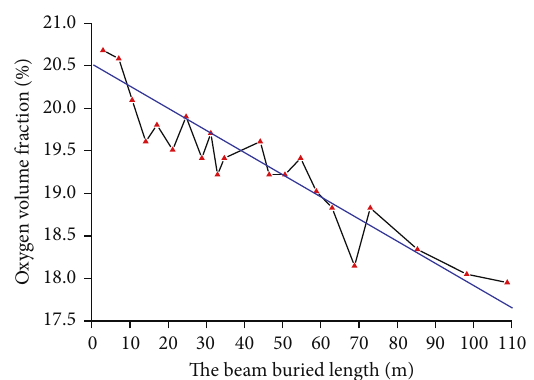
Figure 2: Oxygen volume fraction in goaf, monitored by beam